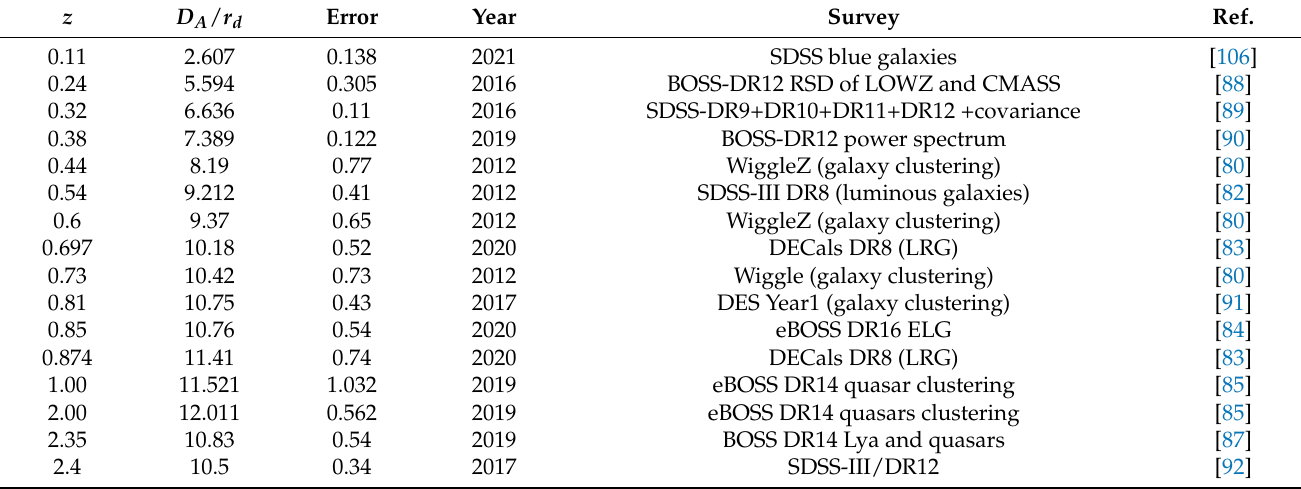
Table A1. The uncorrelated dataset used in this paper. For each redshift, the table presents the parameter, the mean value, and the corresponding error bar. The reference and the collaboration are also reported.